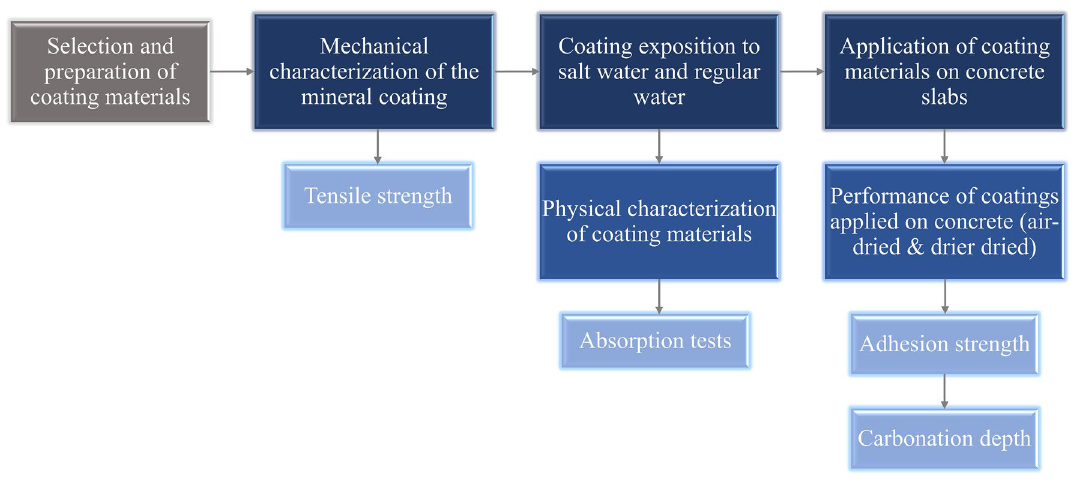
Figure 2. Methodology process